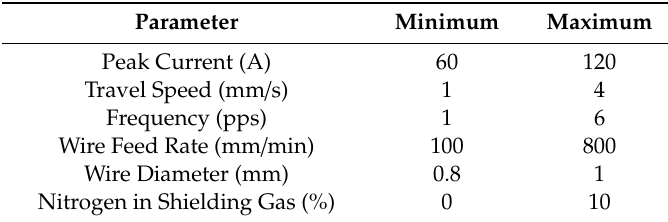
Table 2. Parameter ranges used for experiments.